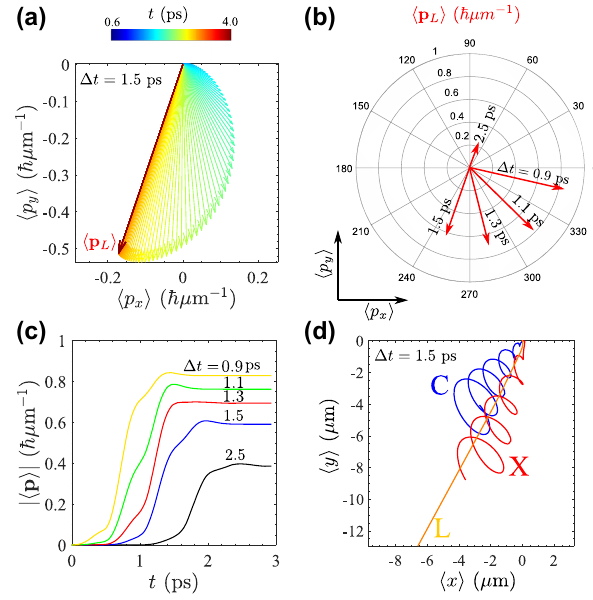
Figure 3: (a) Creation, evolution and stabilization of the NTLM vector,hereforthelowerpolaritonfield.Thefinaldirectionisshown by the red vector. (b) Different values of Δ t (time delay between the pulses) yield different fi nal NTLM directions. (c) Amplitude of the totallinearmomentum ⟨ p ⟩ = ⟨ p C ⟩ + ⟨ p X ⟩ = ⟨ p L ⟩ + ⟨ p U ⟩ fordifferent Δ t . Linear momentum is created with the second pulse and remains constant when its direction stabilizes. (d) Wavepacket centroids for various fi elds,showingwithcurlycurlyoscillationsofthebare fi elds andstraightlinearmotionforthedressedones(thesmalldeviations in the L direction at earlier times are not visible on this